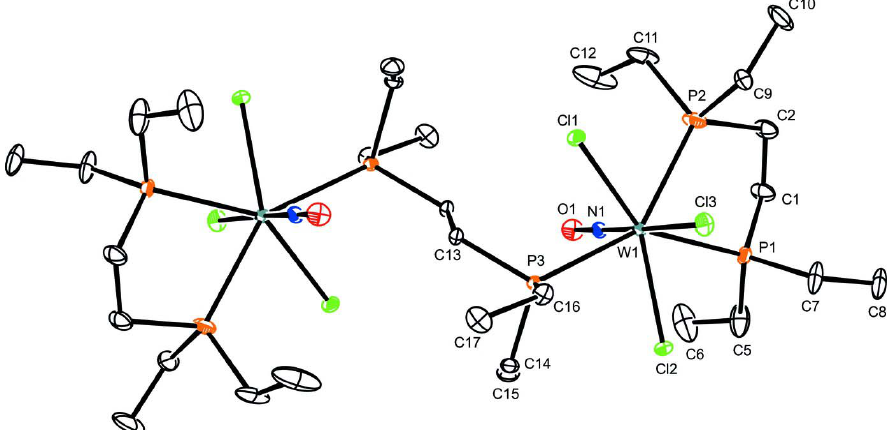
View of the molecular structure of the title compound, showing the atom-labeling scheme and displacement ellipsoids drawn at the 30% probability level. The disordered atoms, C3 and C4, and the hydrogen atoms have been omitted for clarity. Symmetry transformation: - x + 2, - y + 1, - z +